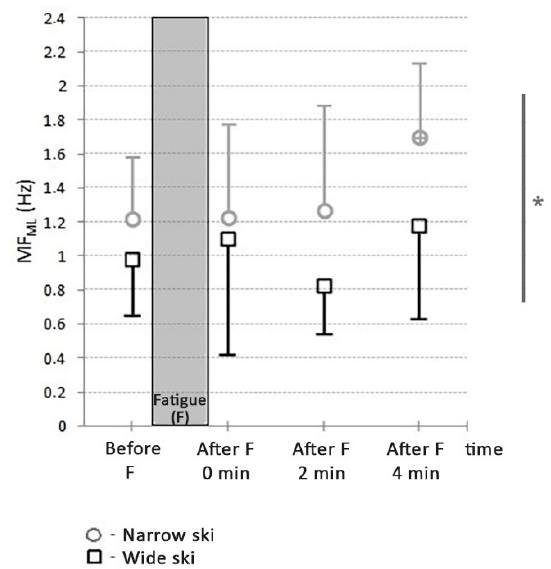
Figure 10. The mean frequency of the power spectrum of CoP in the mediolateral direction (MF ML ) in a prefatigued state (before F) and at different times after fatigue (after F) with two different ski waist-widths. + depicts statistically significant difference compared to prefatigued state ( p < 0.05); * depicts statistically significant difference between all-narrow against all-wide waist-width measurements.